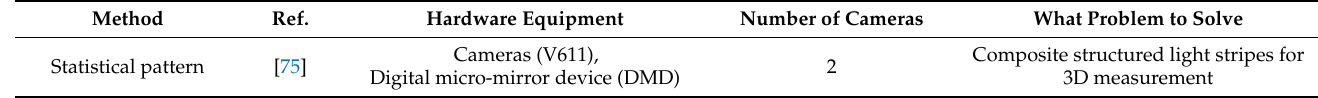
Table 5. Statistical pattern.